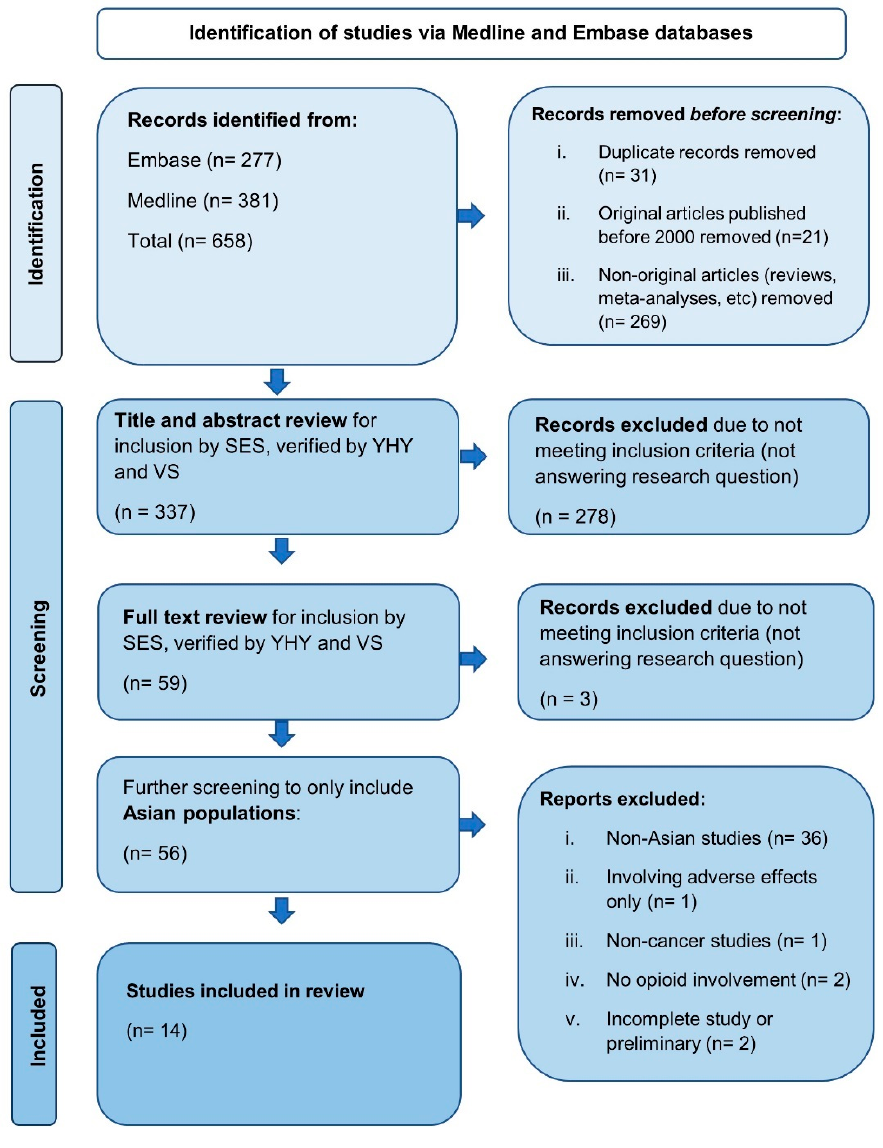
Figure 1. Flow chart of the selection process and search strategy for this study.